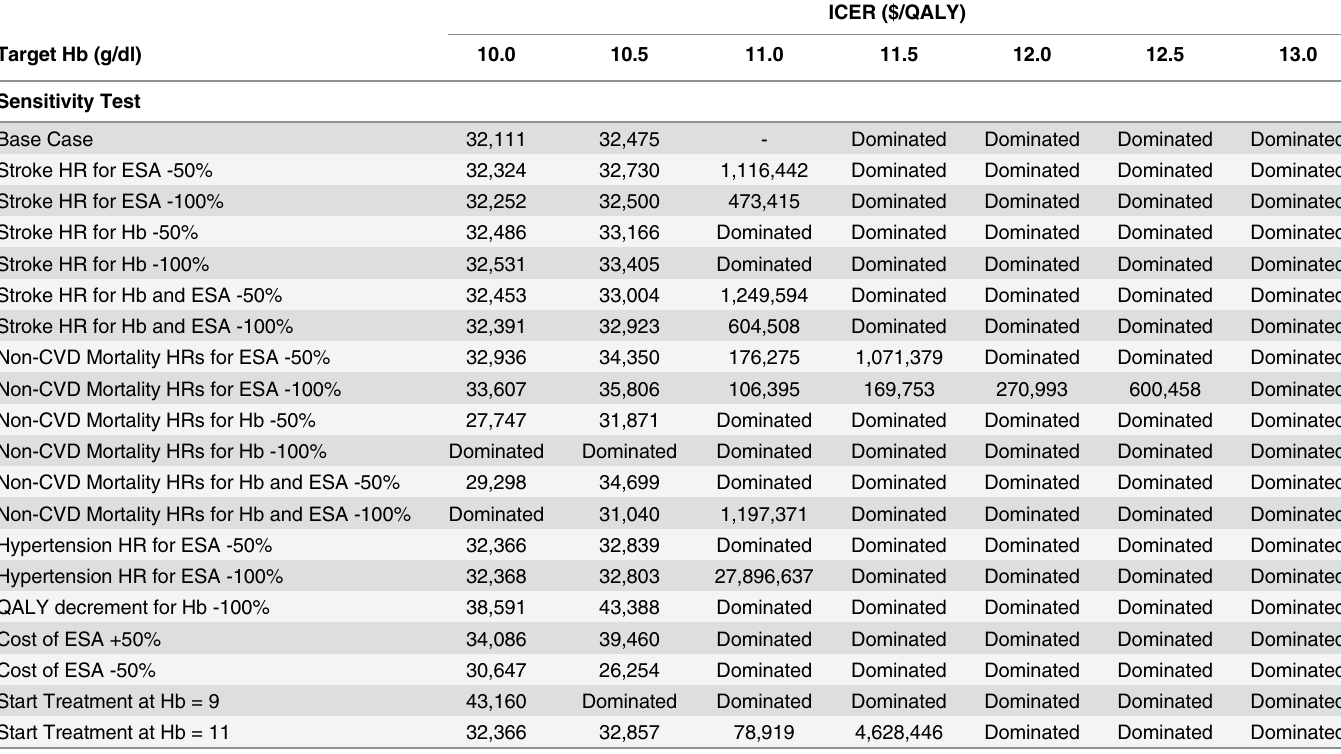
Table 4. One-way sensitivity analyses of cost-effectiveness for different anemia treatment targets.